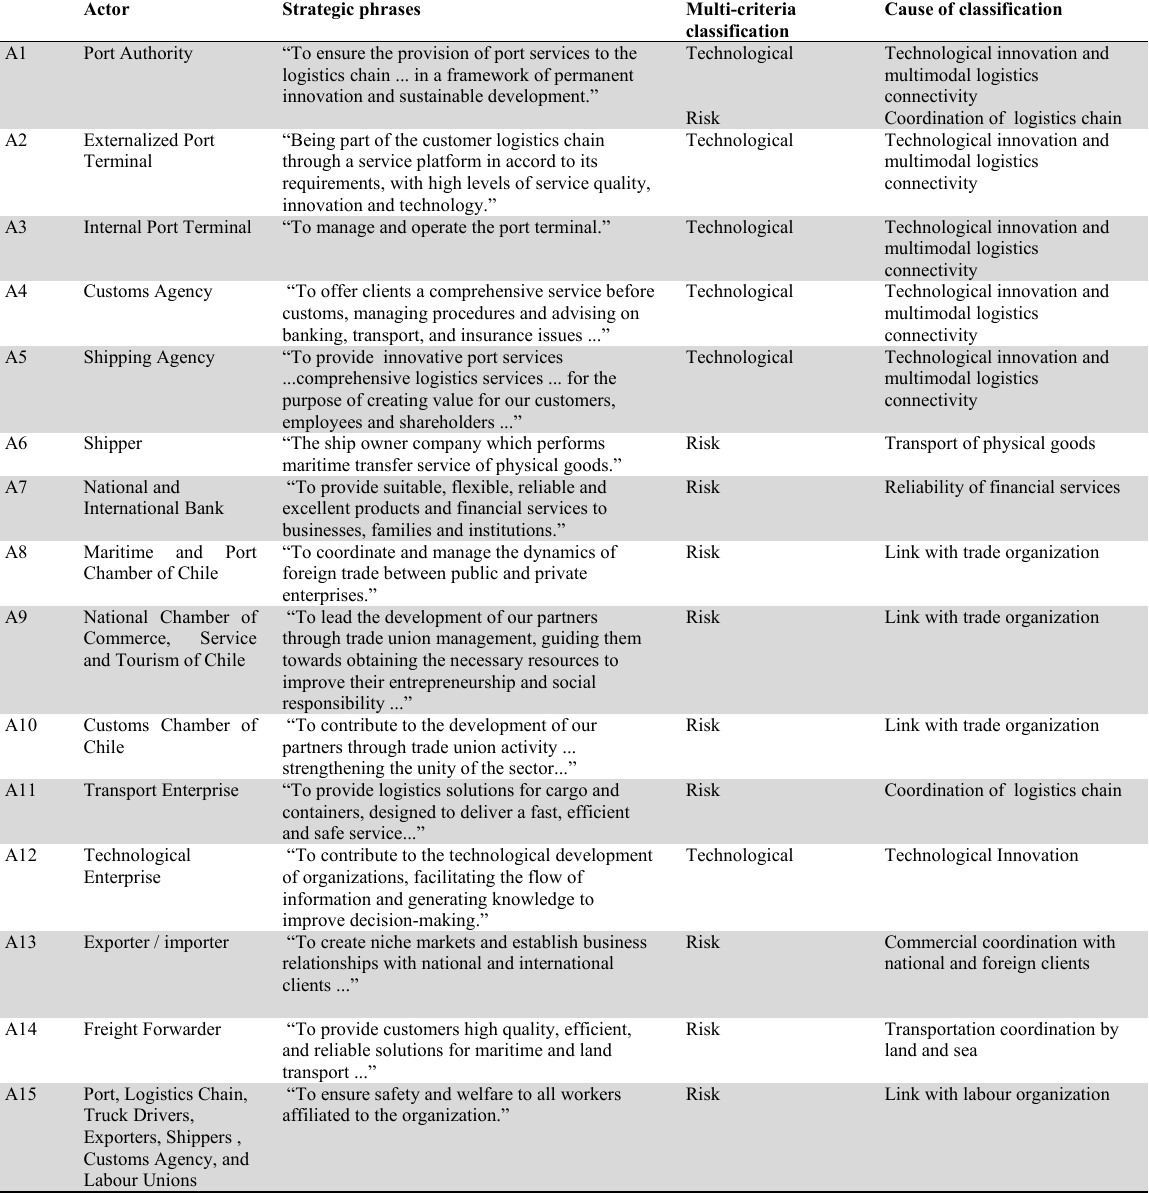
Port private actors declaring technological and/or risk criteria in their strategic